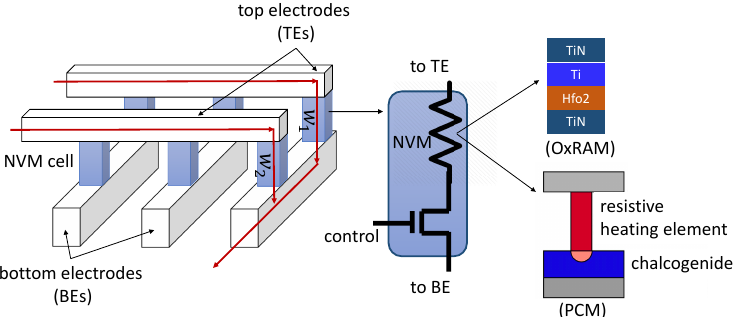
Figure 1. Crossbar organization showing the top and bottom electrodes. Each synaptic cell consists of an NVM device (resistive element) and an access transistor. The NVM device can be implemented using technologies such as PCM or